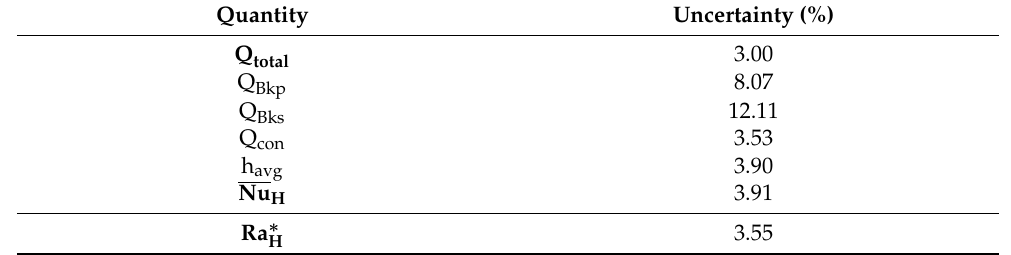
Table 2. The uncertainty results of the variable parameters using the EES